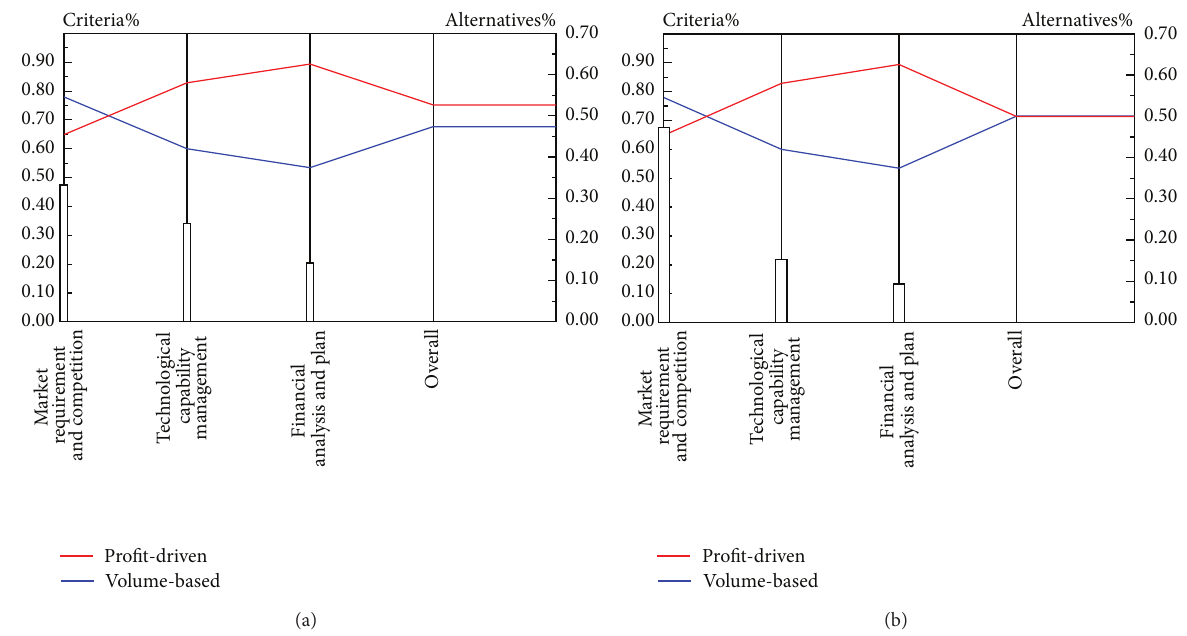
Figure 4: Sensitivity analysis with respect to market requirements and competition.